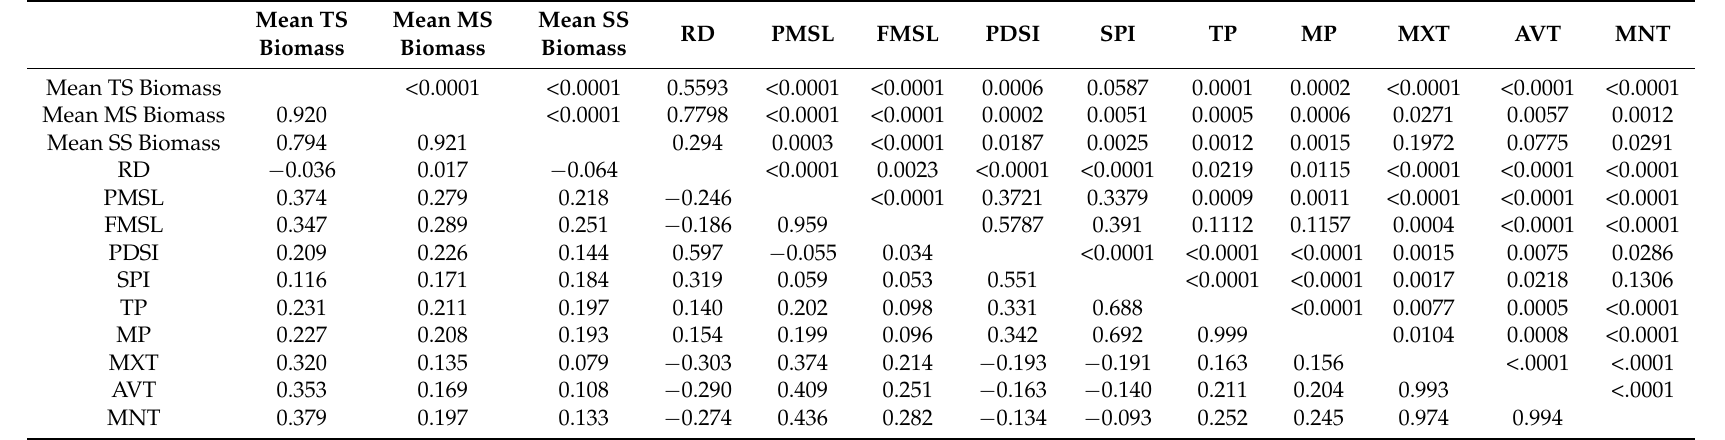
Table A1. Pearson’s correlation coefficients (lower matrix) and probability values (upper matrix) for external drivers and biomass of three S. alterniflora height classes across all dates ( n = 294) from 1984 to 2011. The correlations are estimated by the Pairwise